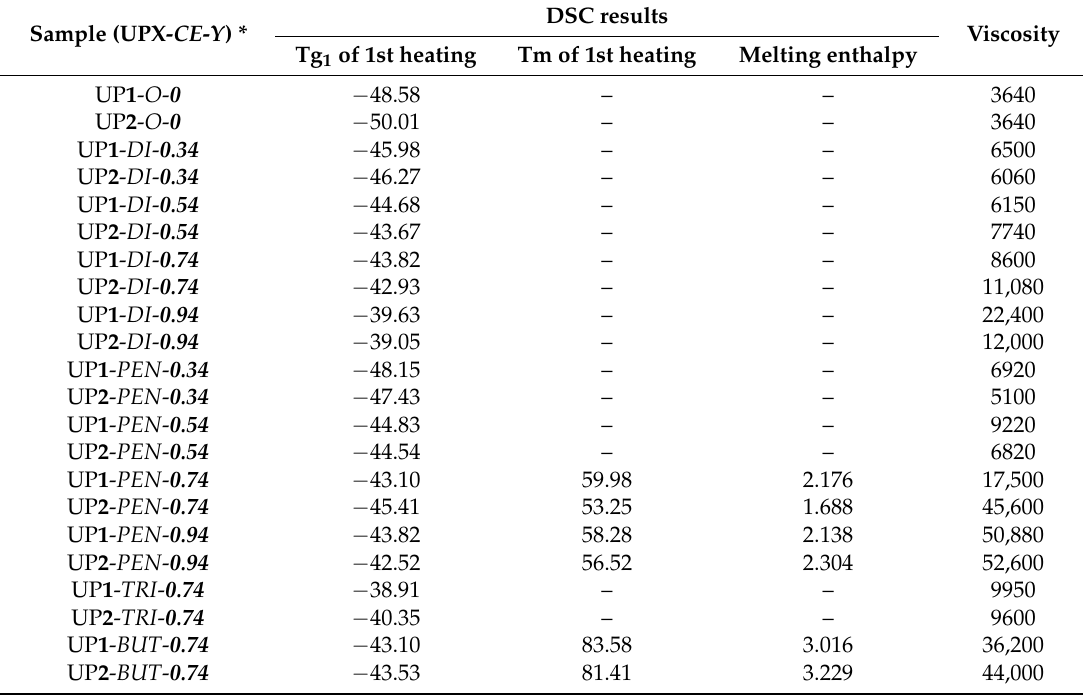
Table 5. Differential scanning calorimetry (DSC) results and viscosity of urethane